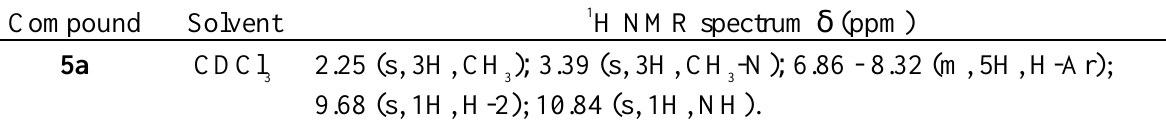
Table 2. 1 H NMR spectra data of prepared